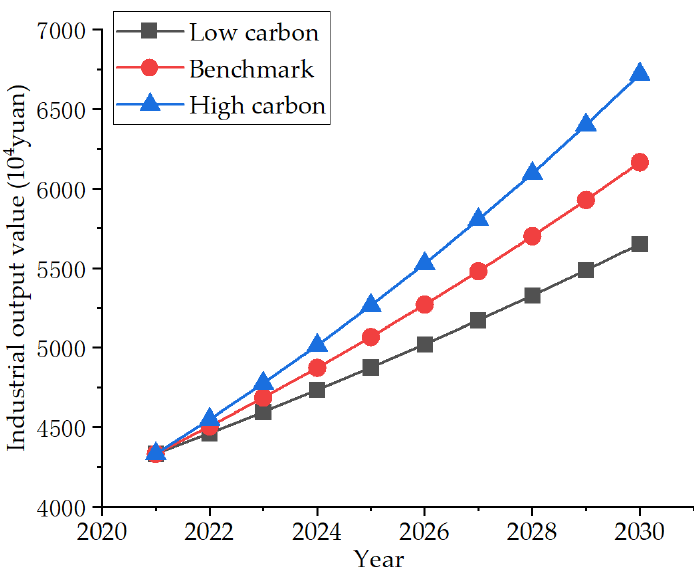
Figure 6. Three industrial output value development scenarios.